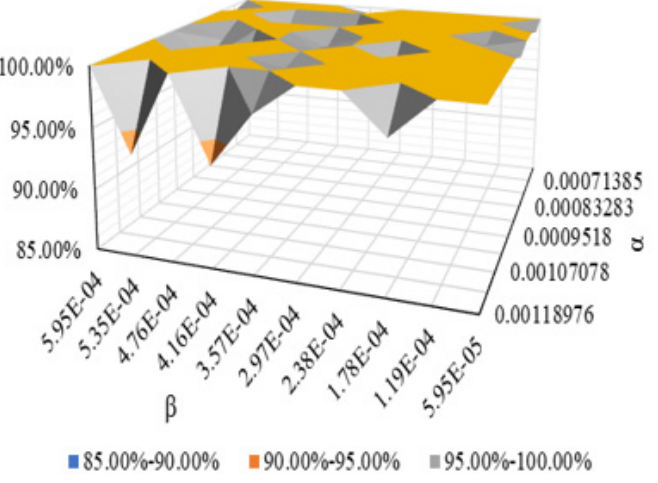
Figure 7. Recall variation chart.